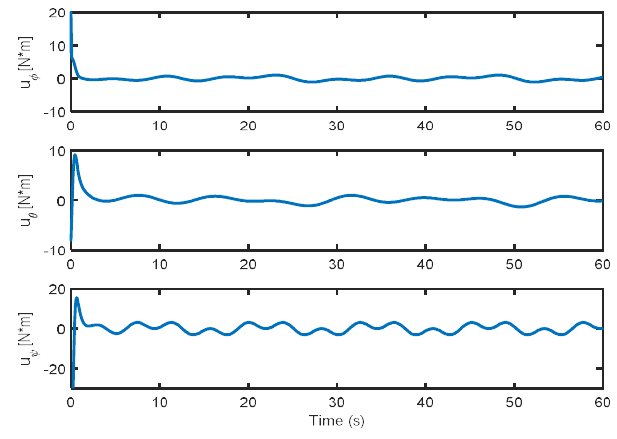
Figure 5. Control inputs.